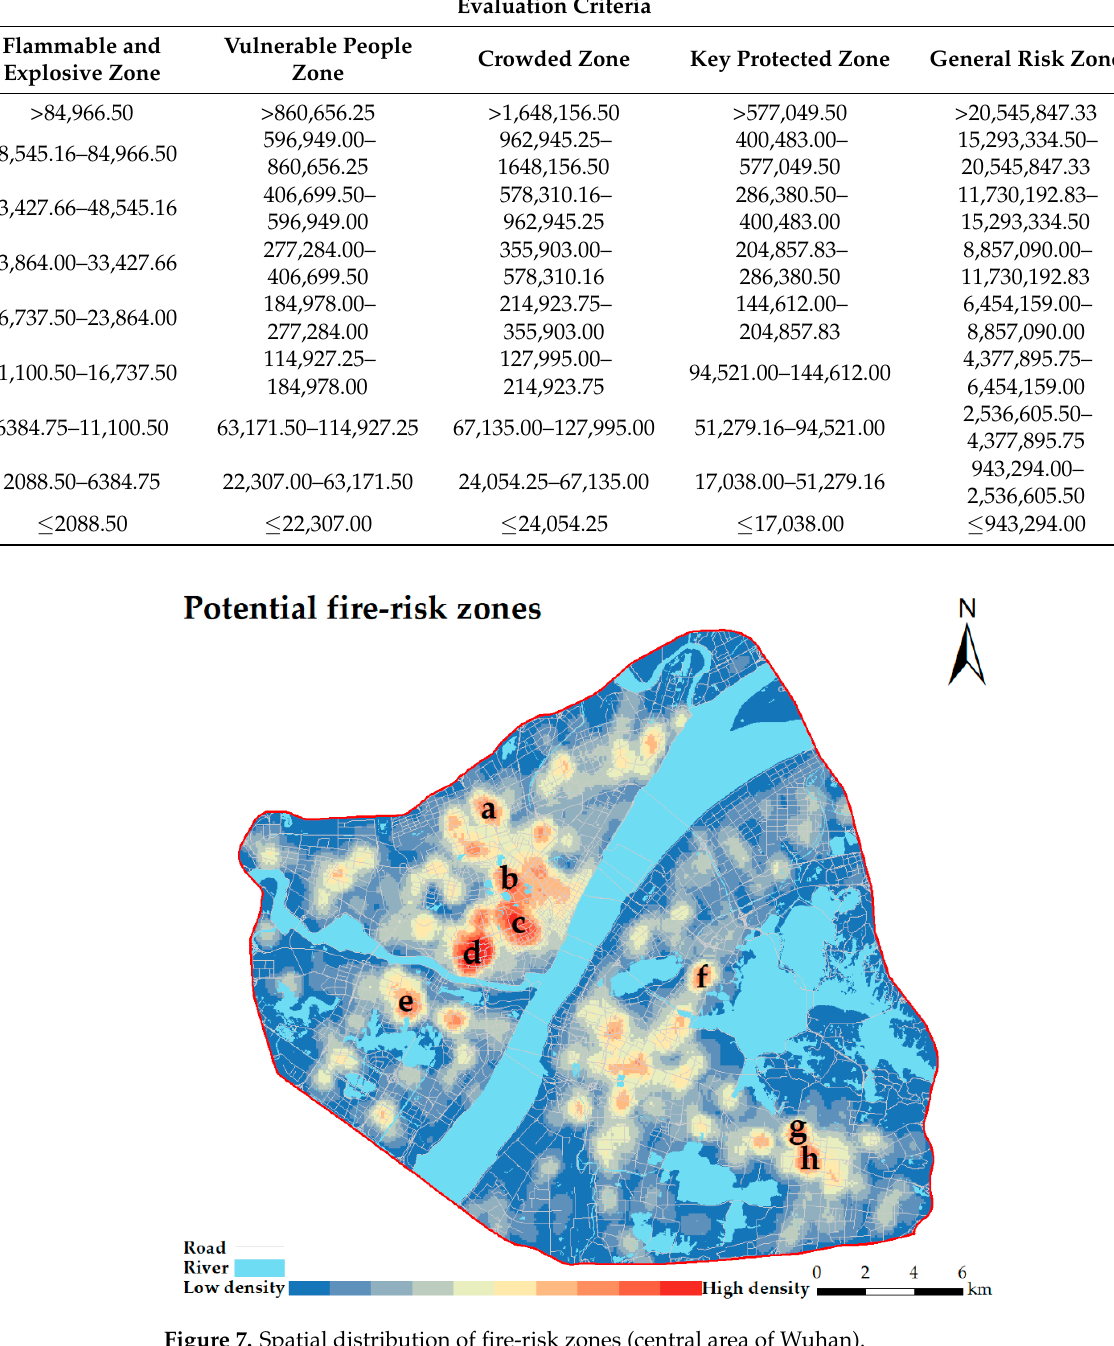
Figure 7. Spatial distribution of fire-risk zones (central area of